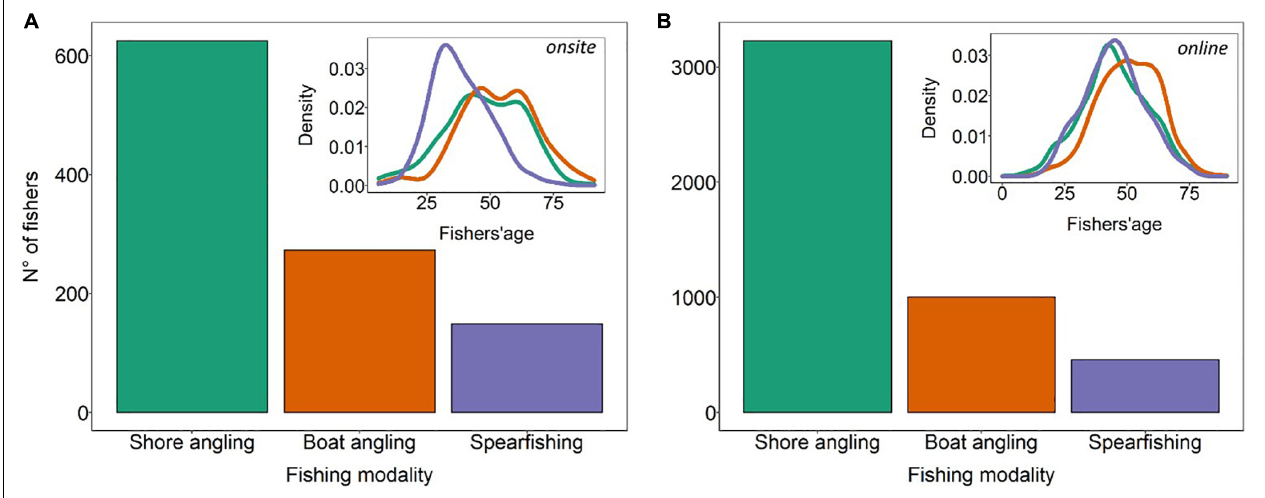
FIGURE 2 | Total number of recreational fishers interviewed during the onsite survey (main plot in A ) and that replied to the online survey (main plot in B ) for each of the three main fishing modalities. Age distributions are presented in the inlets of both panels (A,B) . In the onsite survey (A) , the median ages of spearfishers, shore anglers, and boat anglers were 37, 48, and 53 years, respectively. In the online questionnaire (B) , the median ages of spearfishers, shore anglers, and boat anglers were 45, 44, and 51 years, respectively.